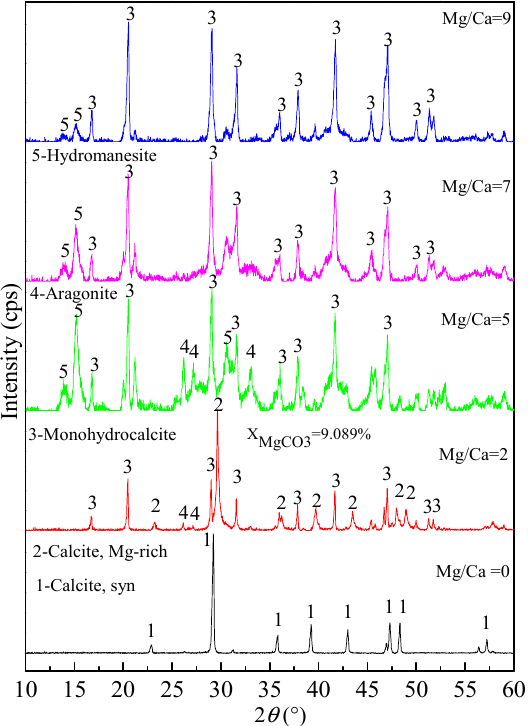
Figure 5. XRD analyses of biominerals cultured for 30